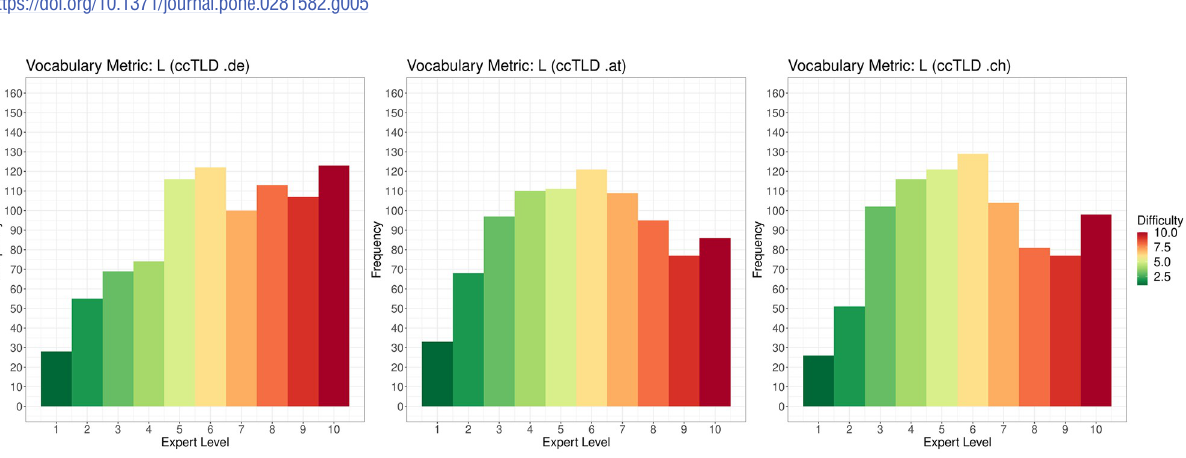
Fig 5. Distribution of readability values on the Vienna formula scale for each ccTLD (“.de”, “.at”, “.ch”). Difficulty is indicated by color, with dark green as the highest readability (4–5) and dark red as the lowest readability (14–15).